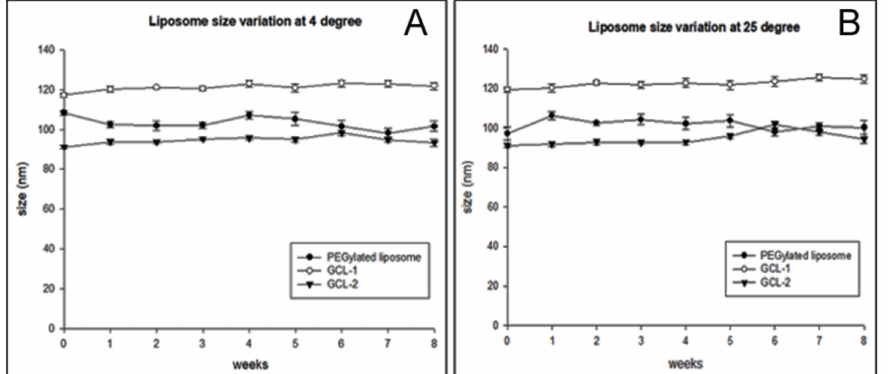
Figure 5. ( A ) Particle size of liposomes during storage at 4 ◦ C for 8 weeks; ( B ) Particle size of liposomes during storage at 25 ◦ C for 8